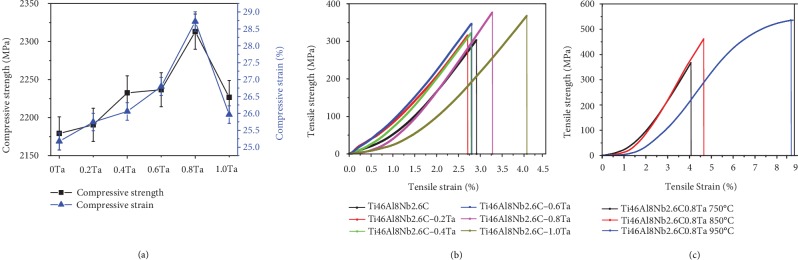
Mechanical properties of the Ti46Al8Nb2.6CxTa alloys: (a) compressive properties; (b) tensile properties at 750°C; (c) tensile properties at 750°C, 850°C, and 950°C.